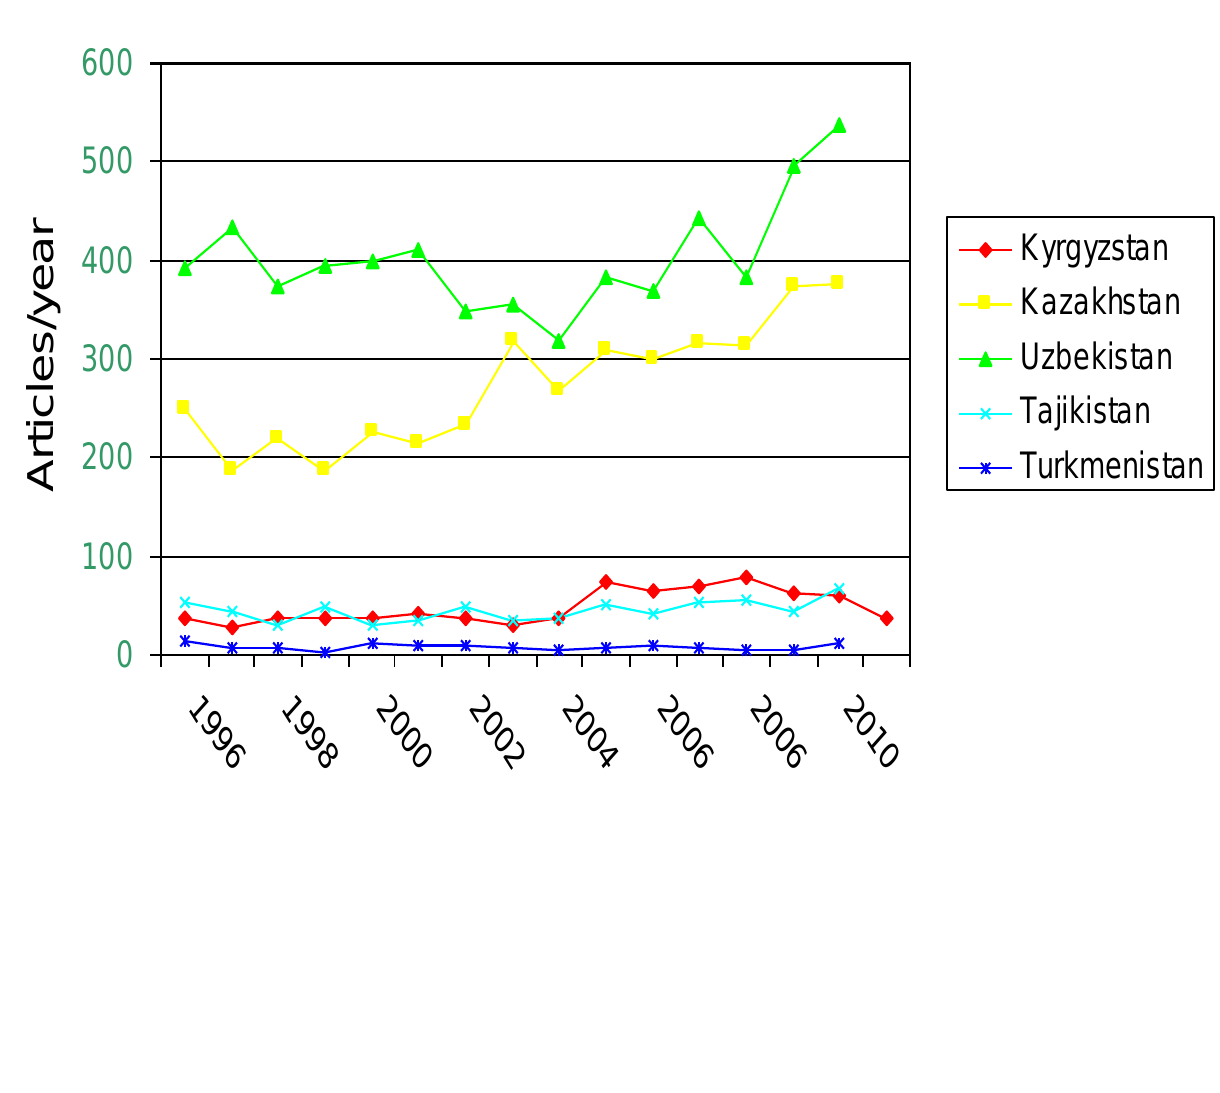
Figure 3: Articles published in the Central Asian countries by year.